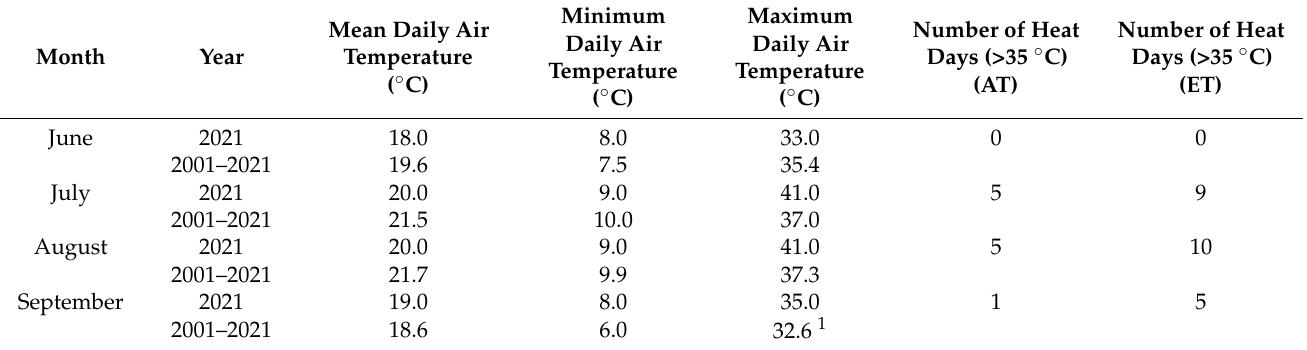
Table 5. Weather conditions during the growing season of 2021 and the average for the same period in the last 20 years (2001–2021). The number of days with temperatures above 35 ◦ C was registered in the ambient (AT) and elevated temperature (ET) modules of the TGG,